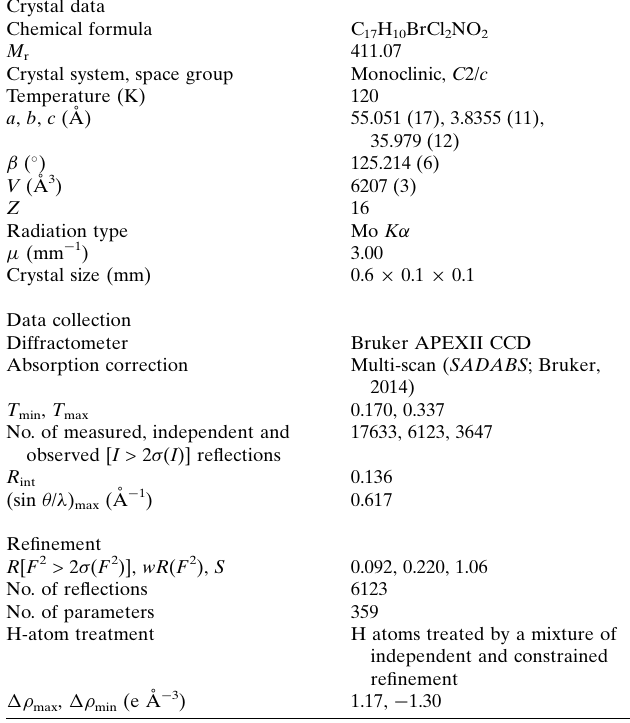
Table 2 Experimental